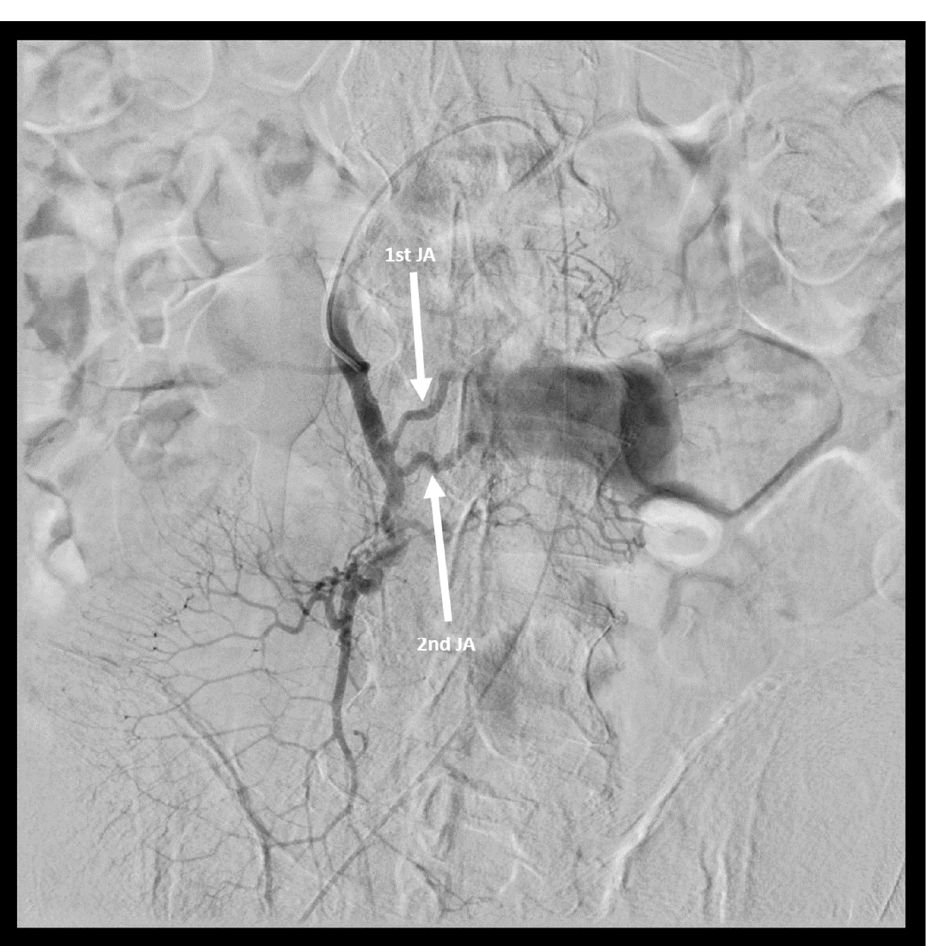
Figure 2. Angiography showing the pseudoaneurysm arising at the level of the 1st and 2nd JA (arrows).